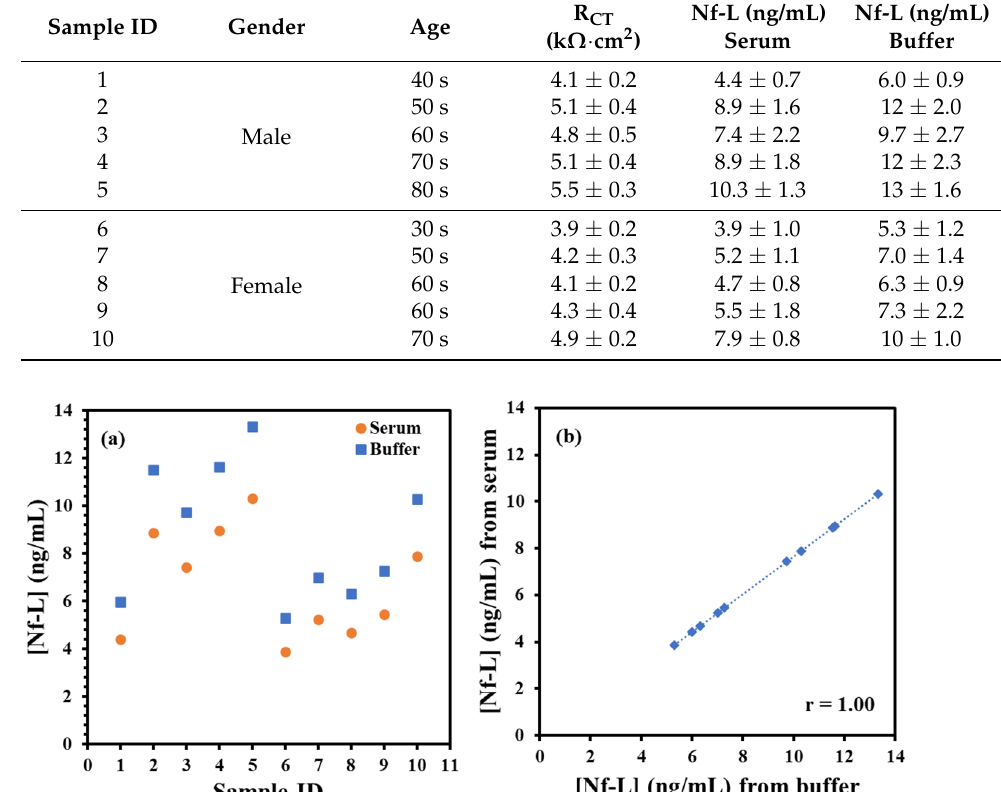
Figure 4. ( a ) Plot of target Nf-L concentration in ALS serum samples. The concentrations calculated from serum-based calibration plot (orange circle) and buffer-based calibration plot (blue square). ( b ) shows correlation plot between the concentration of Nf-L in real ALS samples calculated from serum-based calibration model versus buffer-based calibration model. Pearson correlation coefficient r = 1.00 shows very high correlation between these two media.